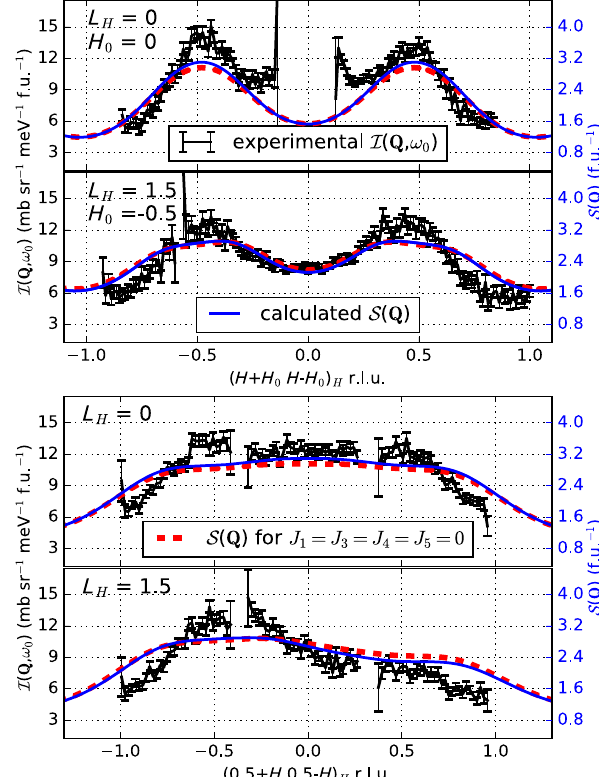
FIG. 6. Cuts through the experimental I ð Q ; ω 0 Þ (black error bars) and the calculated S ð Q Þ (blue lines) for ð V 0 Top (bottom) panels show horizontal (vertical) cuts taken along the corresponding lines indicated in Fig. 4. To show the importance of the dominant exchange constants J 2 ¼ 8 . 5 ð 3 Þ and J 6 ¼ 1 . 7 ð 2 Þ , the red line shows the calculated S ð Q Þ